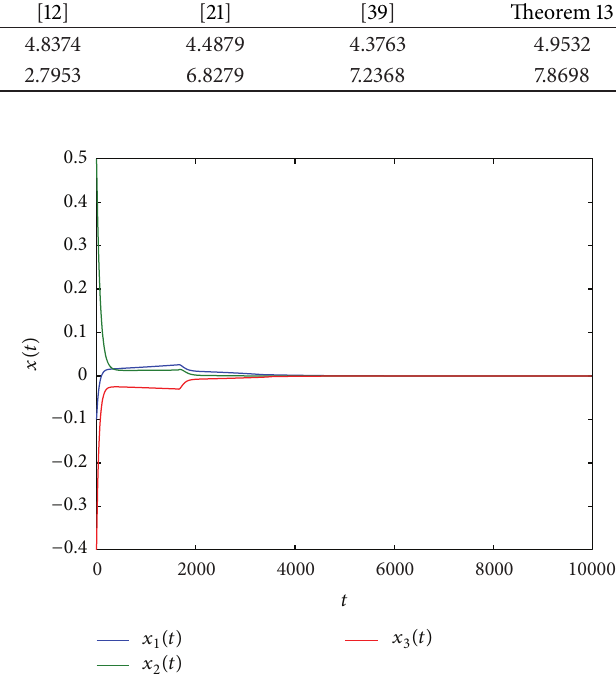
Figure 3: The simulation of Example 2 of Case A for ℎ = 𝑟 = 4.9532 , where the initial value is [−0.2, 0.5, −0.4] 𝑇 , ℎ 𝐷 = 0